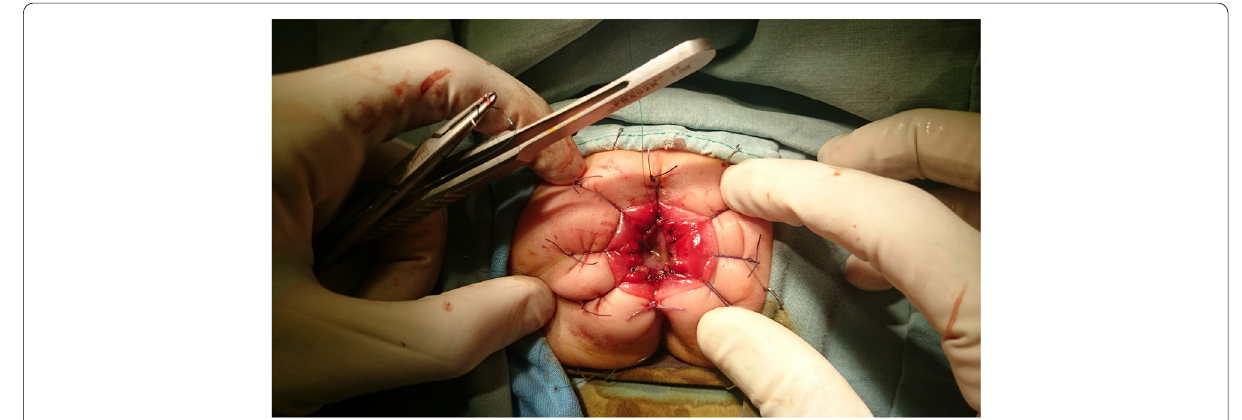
Fig. 3 Final result, transanal anorectoplasty